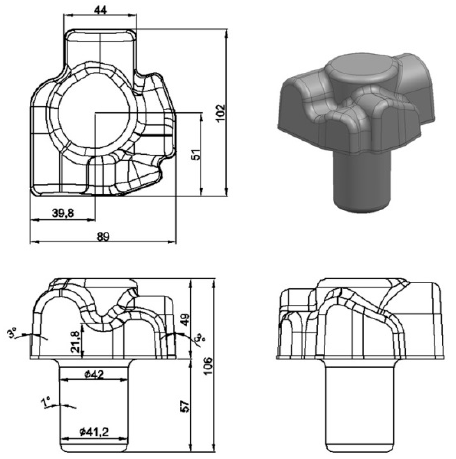
Figure 1. Drawing of the umbrella-shaped part.